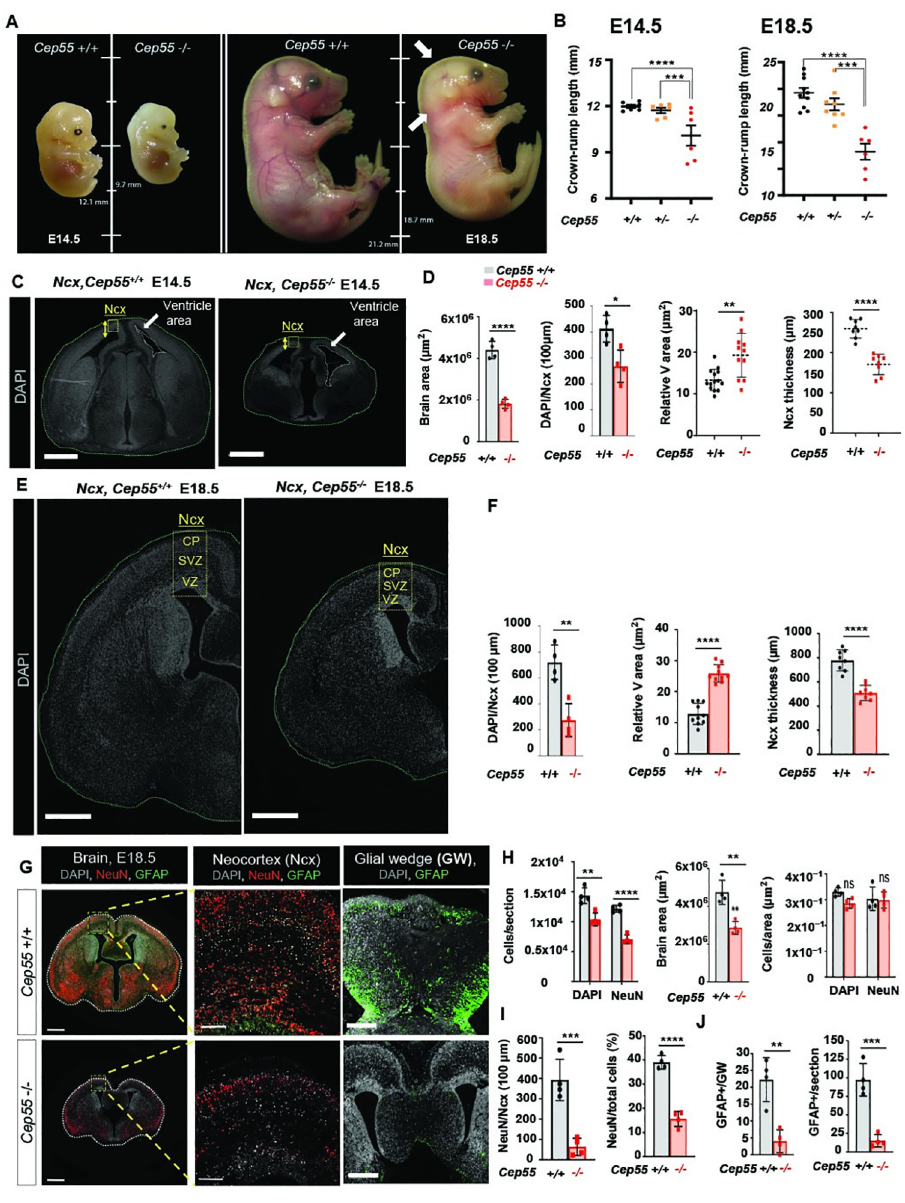
Fig 1. Loss of Cep55 leads to preweaning lethality and microcephaly in mice. (A) Comparison of size (length, mm) and morphology of E14.5 (left) and E18.5 (right) Cep55 +/+ and Cep55 -/- embryos. (B) Comparison of the crown-rump length (mm) of E14.5 (left, p < 0.0001) and E18.5 (right, p < 0.0001) Cep55 +/+ and Cep55 -/- embryos. Data represent the mean ± SD, n = 6–10 embryos per genotype. (C,E) Representative images of Cep55 +/+ (left) and Cep55 -/- (right) neocortices (Ncx, yellow box) showing relative size of the Ncx. The yellow two-sided arrow represents the thickness of the Ncx, green dashed line shows the brain area, white dashed line shows the ventricle area and the yellow box resembles the analysis area, (C) Representative images of Cep55 +/+ and Cep55 -/- mouse brains at E14.5, scale = 50 μ m. (D) Comparison of brain area of Cep55 +/+ and Cep55 -/- E14.5 embryonic brains (left, p < 0.0001), and quantification of brain cell density (DAPI count within 100 μ m 2 area of the neocortex) (Middle left, P < 0.0118) Quantification of the relative ventricle area ( μ m 2 ; total area shown/total brain area) (Middle right, p < 0.0011), and Ncx thickness (right, p < 0.0001). (E) Representative images of Cep55 +/+ and Cep55 -/- mouse brains at E18.5, scale = 700 μ m. (F) Comparison of Cep55 +/+ and Cep55 -/- for left: total DAPI+ cell count in the Ncx, p < 0.0029; middle: relative ventricle area ( μ m 2 ; total ventricular space/total brain area), p < 0.0001; and right: Ncx thickness, p < 0.0001. (G) Representative images of whole coronal section (left), boxed region at increased magnification (middle), and medial region/glial wedge (right) of E18.5 Cep55 +/+ (upper) and Cep55 -/- (lower) embryonic mouse brains. Images